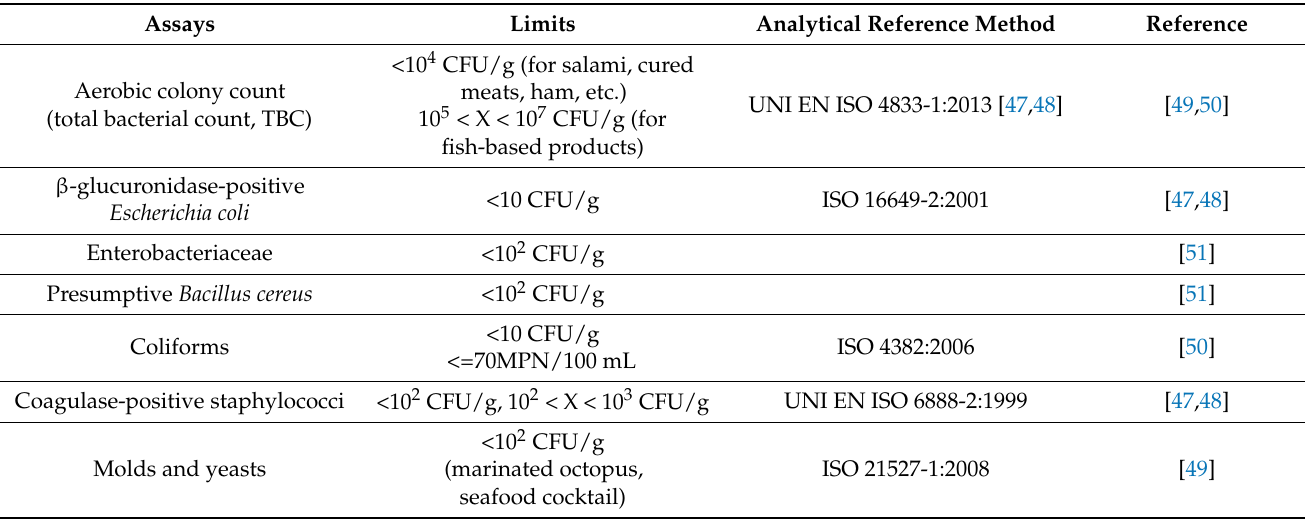
Table 3. Main parameters chosen for safety analysis of fermented Jellyfish paste